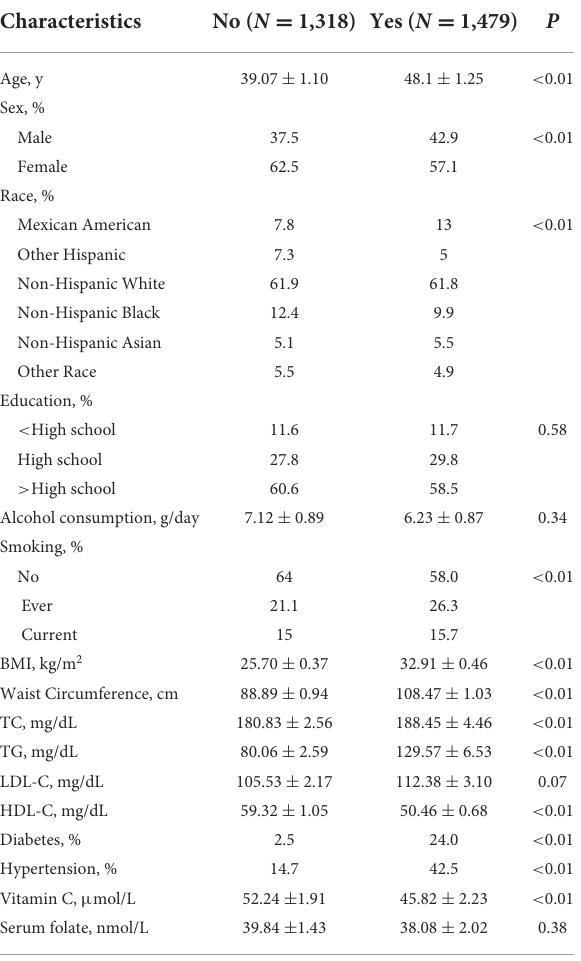
TABLE 1 Basic characteristics of participants according to